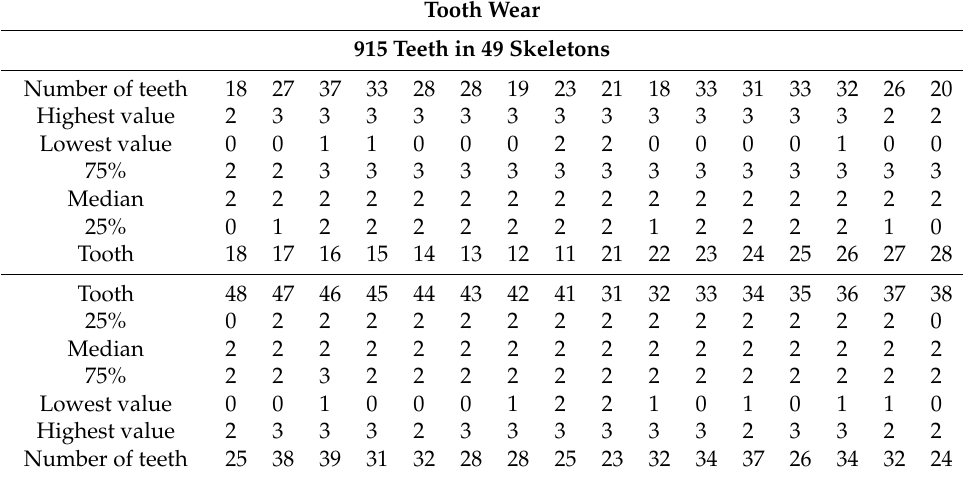
Table 2. Tooth wear for each tooth number according to the classification: 0 no wear, 1 wear in enamel, 2 dentin exposed and 3 exposure of pulp